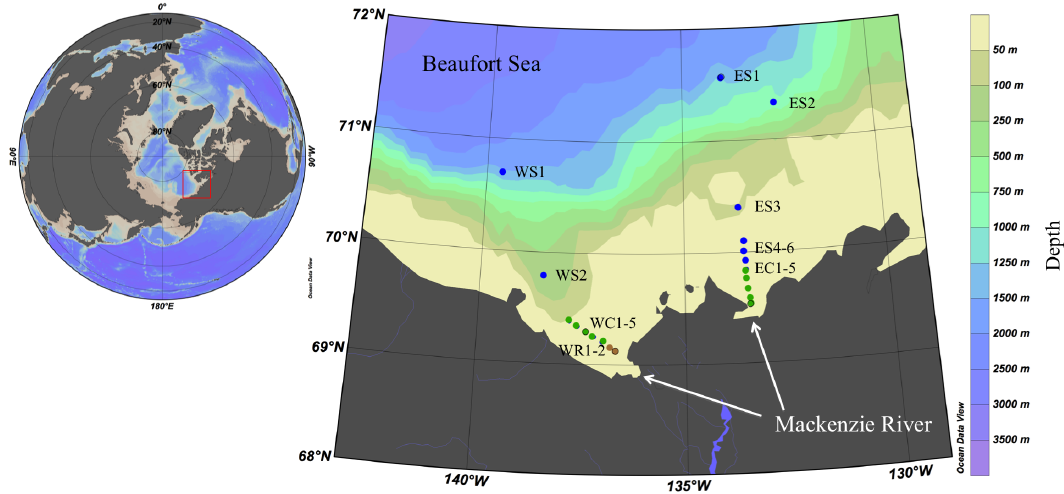
Fig. 1. Study area and station locations. Blue dots: stations considered as “open sea”. Green dots: stations considered as “coast”. Brown dots: stations considered as